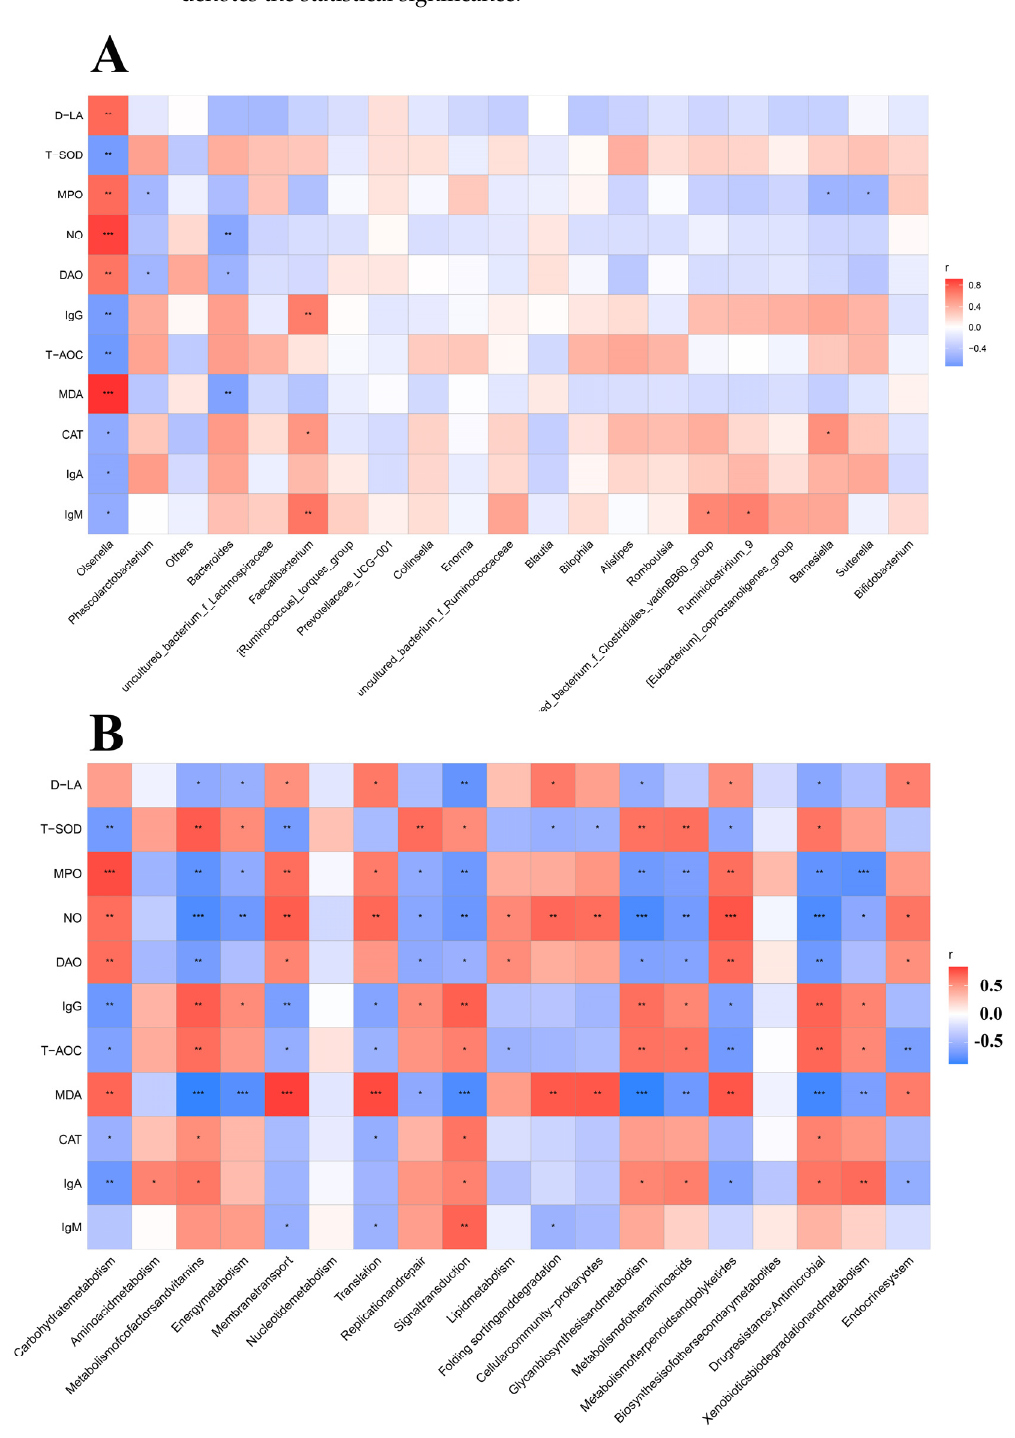
Figure 12. Pearson’s correlation analysis. Correlation of phenotypic variables and microbial com- munities ( A ) and microbial-predicted metabolic pathway functions ( B ). The color and the dot size represent the correlation coefficient. * p < 0.05, ** p < 0.01, *** p < 0.001.